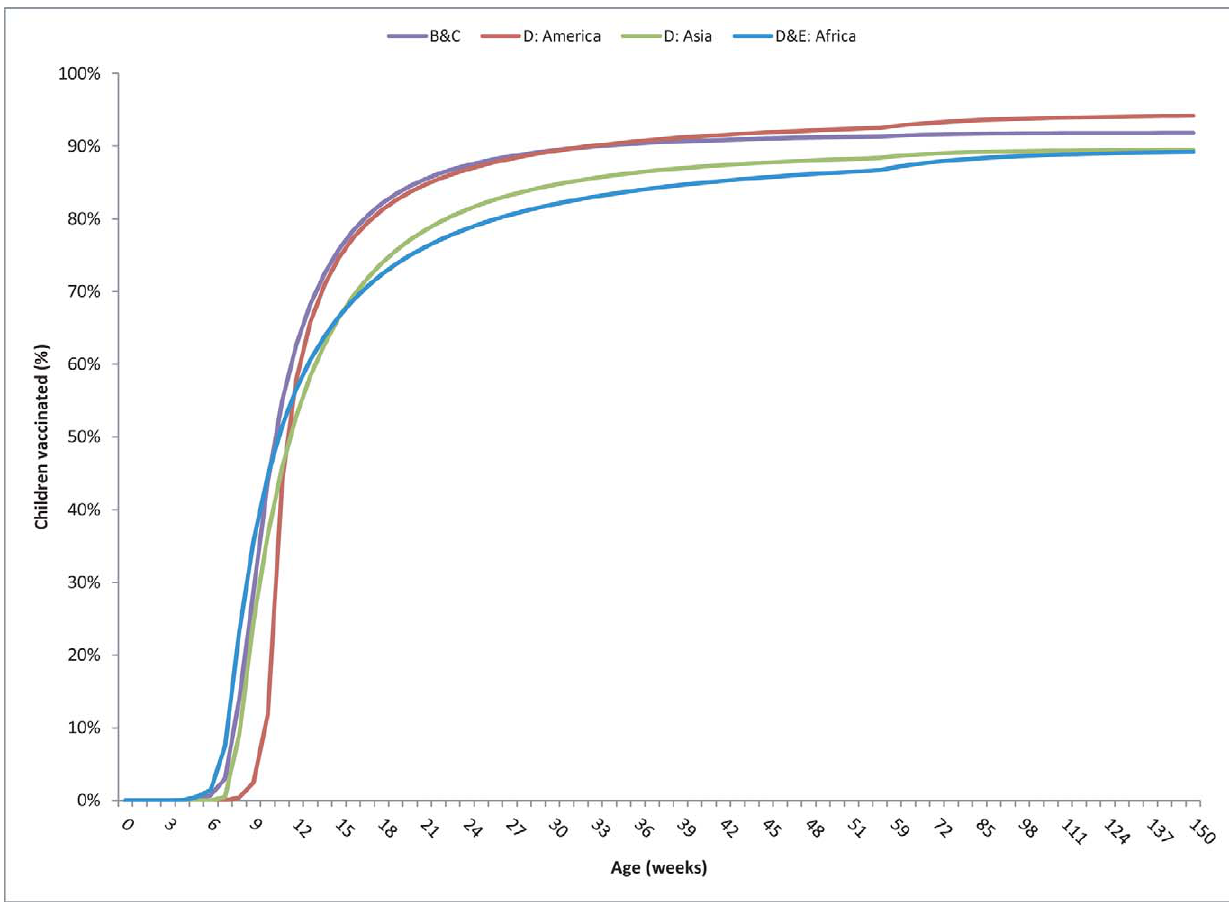
Figure 2. Vaccine coverage for dose 1 of DTP by week of age and WHO mortality group based on the DHSs and UNICEF MICs.